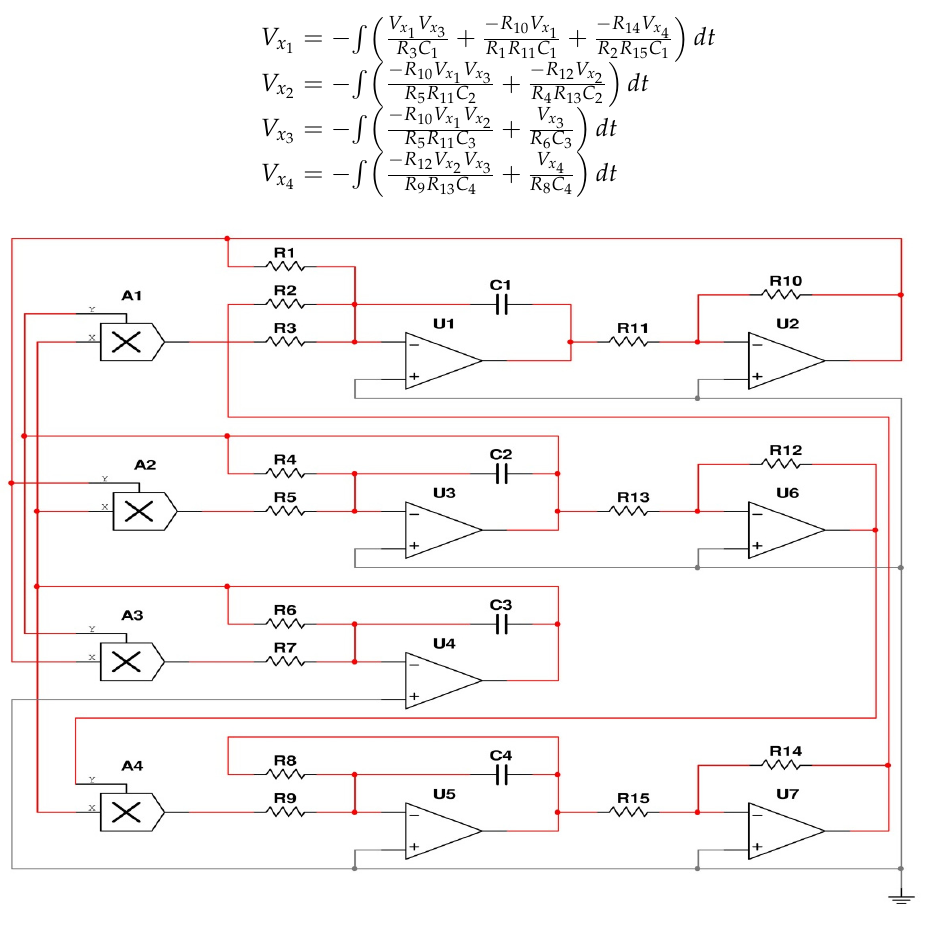
Figure 3. Circuit configuration of the four-dimensional Chen–Lee system designed on Multisim. The components of the chaotic circuit are chosen to be: R1 = R3 = R4 = R5 = R8 = R9 = R10 = R11 = R12 = R13 = R14 = R15 = 100 k, R2 = 204 k, R6 = 267 k, R7 = 330 k and C1 = C2 = C3 = C4 = 0.471 uF. The voltage output signals of the chaotic circuit simulated in Multi-